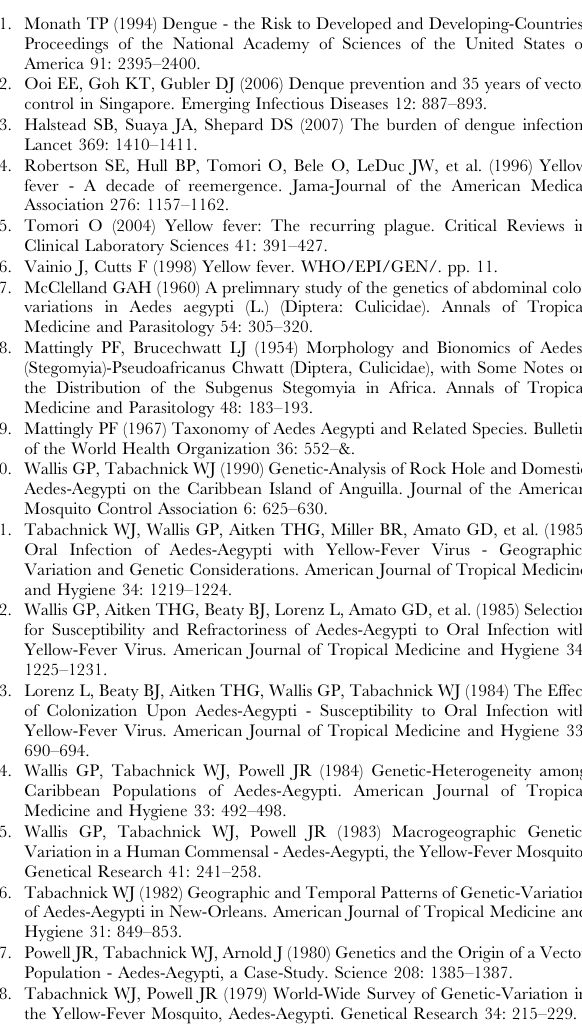
Figure S1 Maximum likelihood tree of the 117 mtDNA ND4 Ae. aegypti haplotypes discovered to date and outgroups. Haplotypes collected only in Africa appear in red, South America in blue, North America in gold, Southeast Asia in purple and those collected in more than one geographic area in green. All of the NUMTS found in GenBank to date appear as olive drab and are labeled NUMT. Branches with bootstrap support values . 50% are labeled with % support. Maximum likelihood branch lengths are proportional to the number of nucleotide substitutions per site. The scale at the bottom of this figure is from 0.0–0.07. Figure S2 Bayesian tree of the 117 mtDNA ND4 Ae. aegypti haplotypes discovered to date and outgroups. Haplotypes collected only in Africa appear in red, south America in blue, North America in gold, Southeast Asia in purple and those